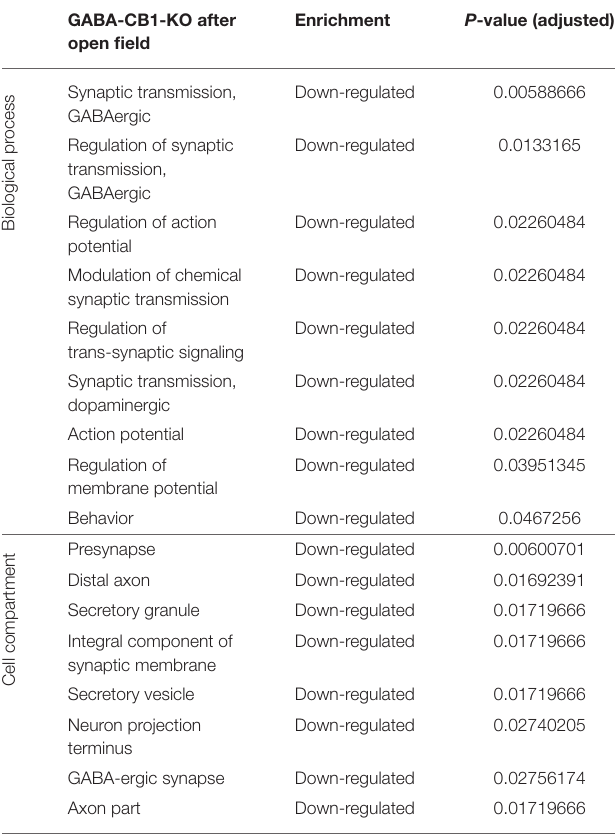
Table showing the list of GO terms resulting after analyzing the DEGs in the comparison GABA-CB1-KO vs. CB1-WT after open field exposure. GO terms marked as downregulated indicate that these terms are enriched for downregulated DEGs, and the opposite holds true for terms marked as